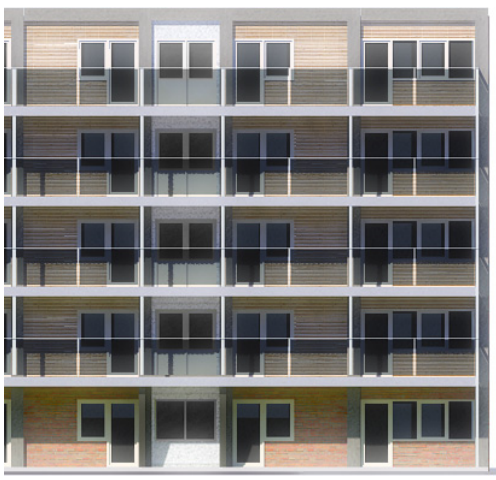
Figure 16. Back façade (east) of the refurbishment